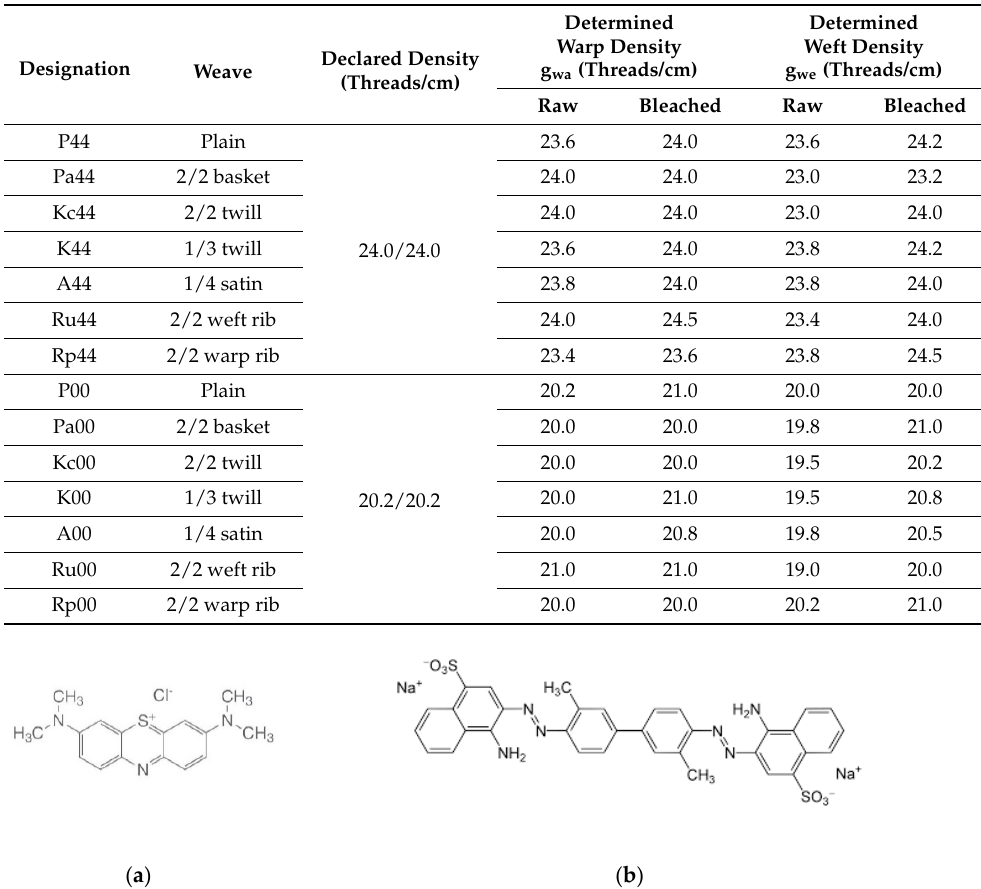
Table 1. Woven fabric samples labels, weave and thread densities.